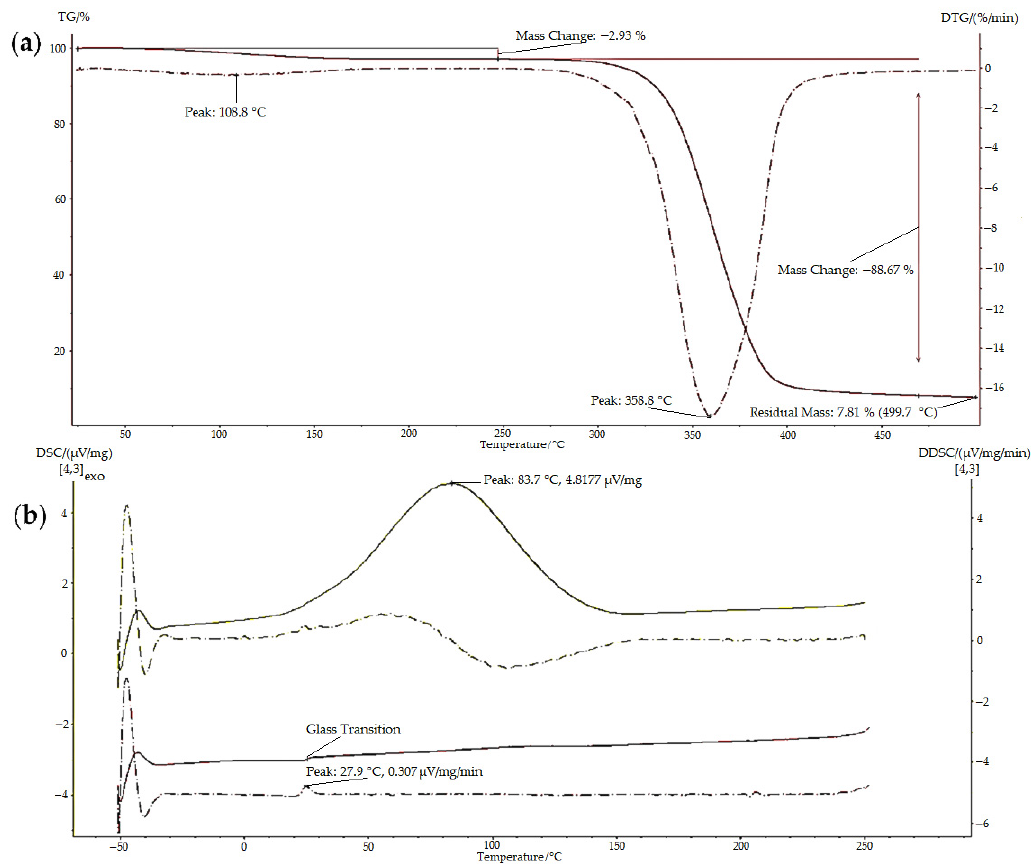
Figure 6. Representative thermal analysis results for BMO-PUL: ( a ) TGA thermogram: 1st derivative TG (DTG) depicted as a dotted line and ( b ) DSC curves (top: 1st run and bottom: 2nd run).